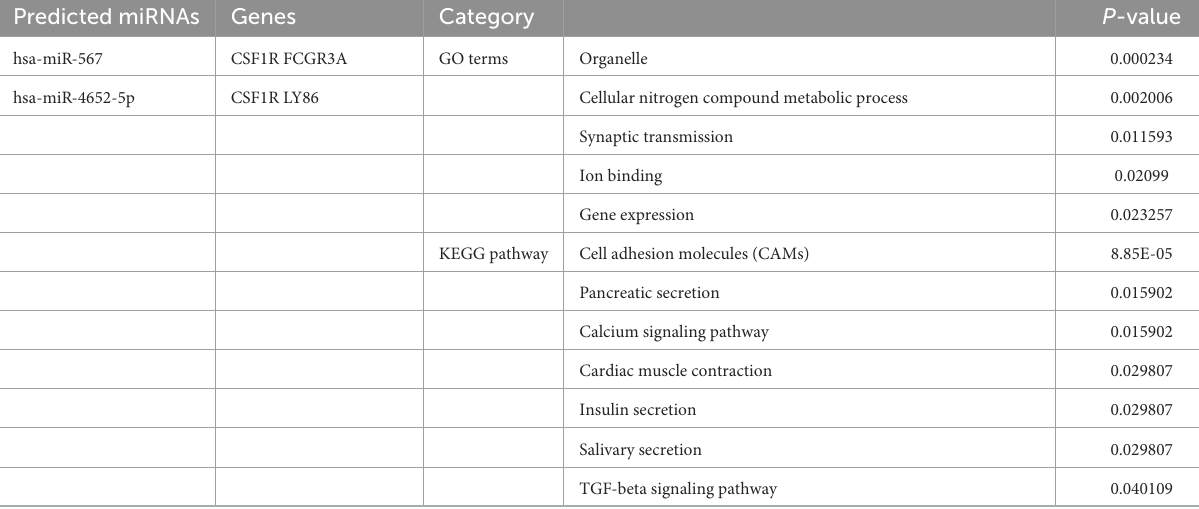
TABLE 1 The GO terms and KEGG pathways enrichment among predicted miRNAs and